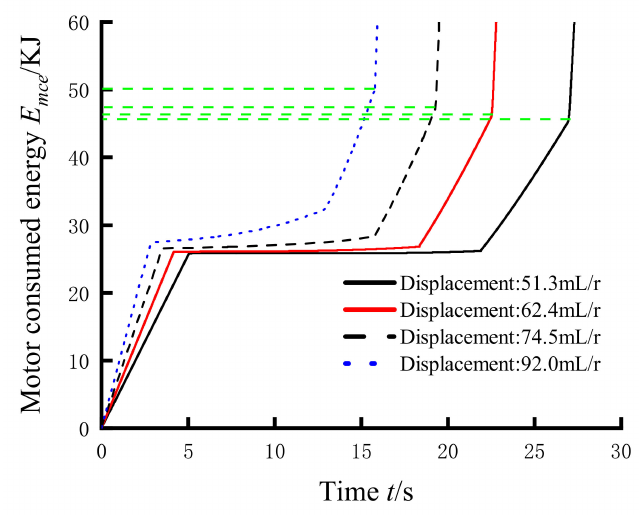
Figure 13. Energy consumption with different displacement of